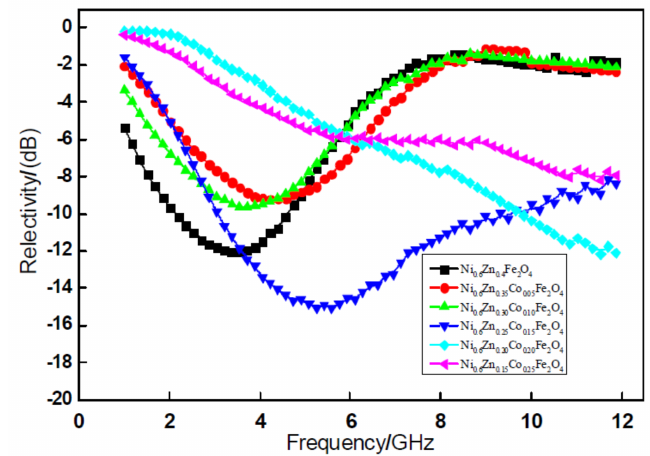
Figure 4. Curves of reflectivity and frequency for the Ni 0.6 Zn (0.4 − x) Co x Fe 2 O 4